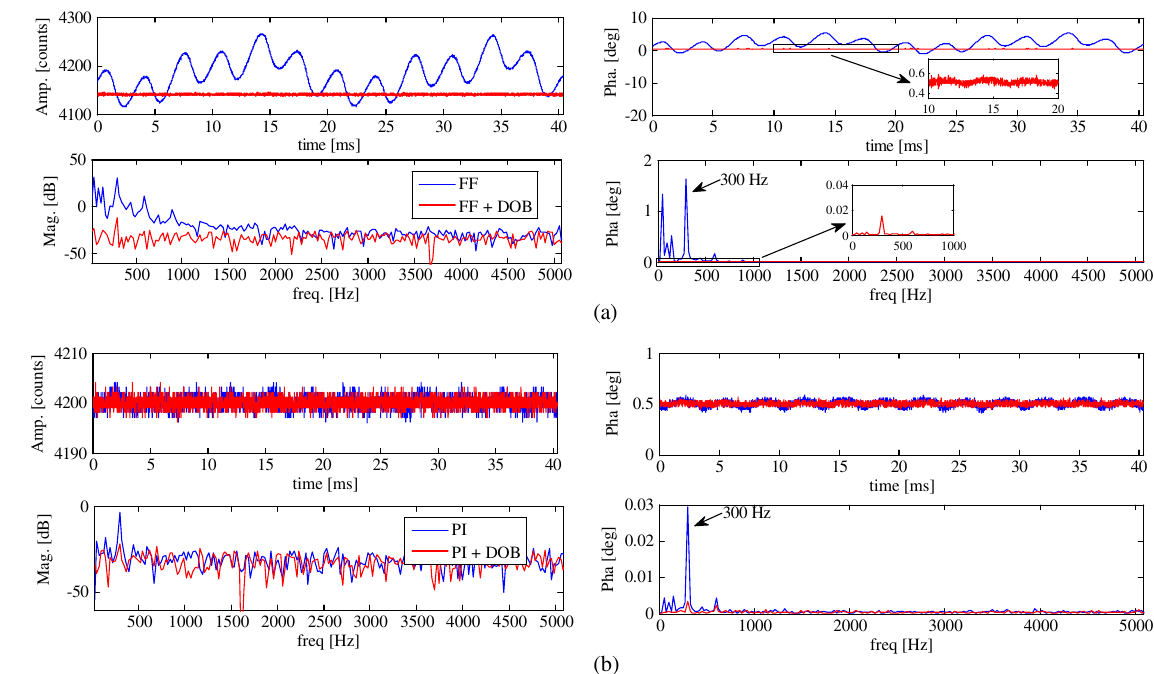
FIG. 16. Original FF/FB control (blue) vs FF = FB þ DOB control (red). Radio-frequency field performance in amplitude and phase is plotted, as well as their corresponding FFT analyses. (a) Under the operation of FF control ( f indicate DOB off and on, respectively. (b) Under the operation of FB control ( f feedback control and PI þ DOB control, respectively.